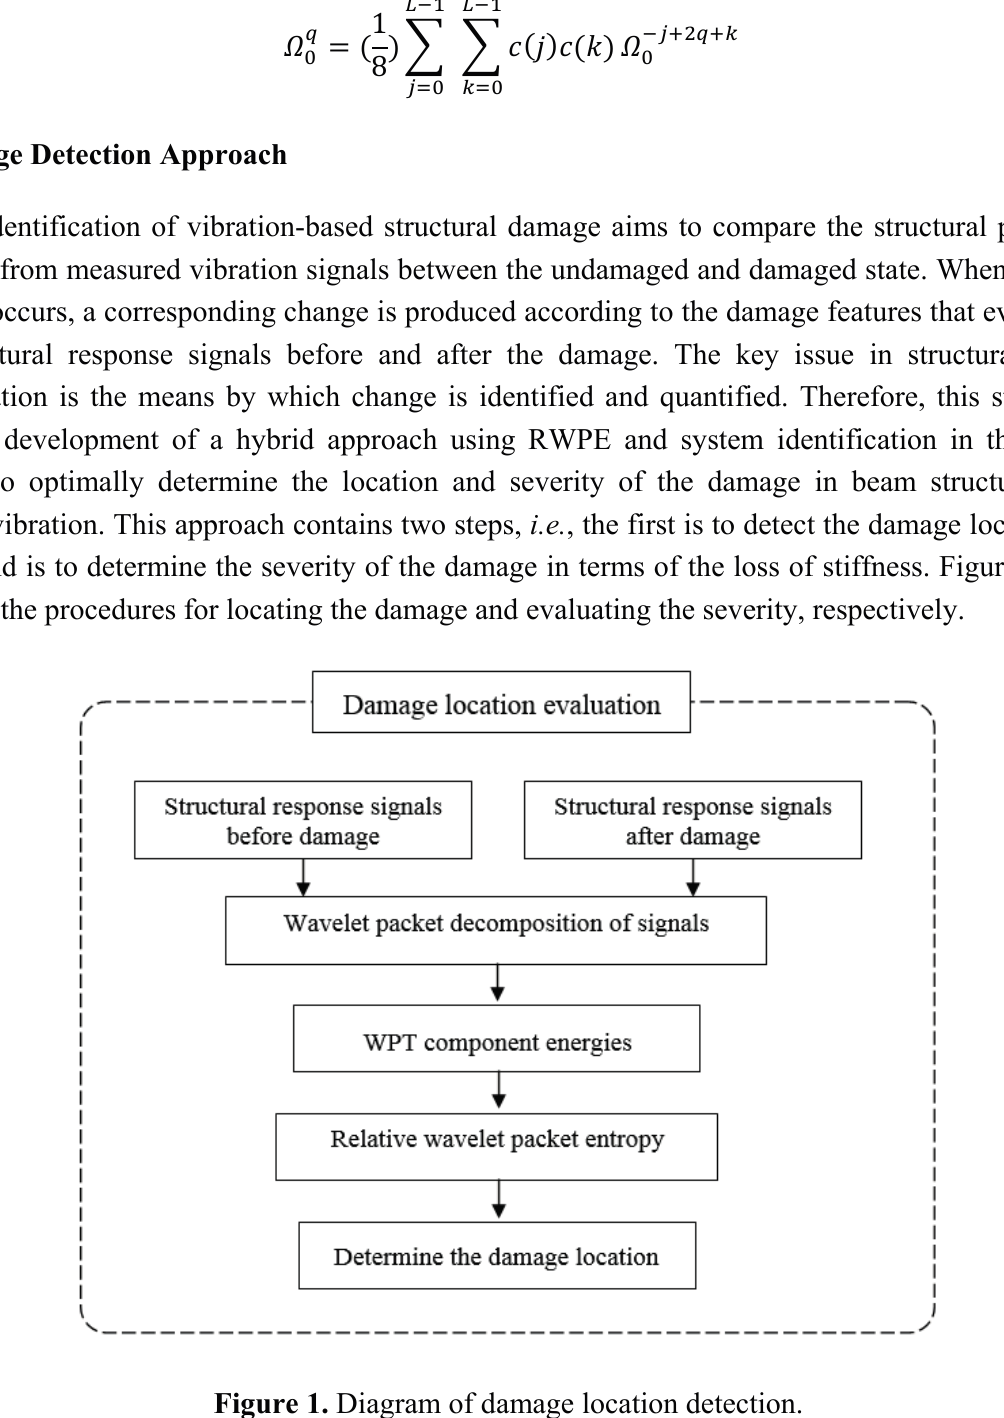
Figure 1. Diagram of damage location